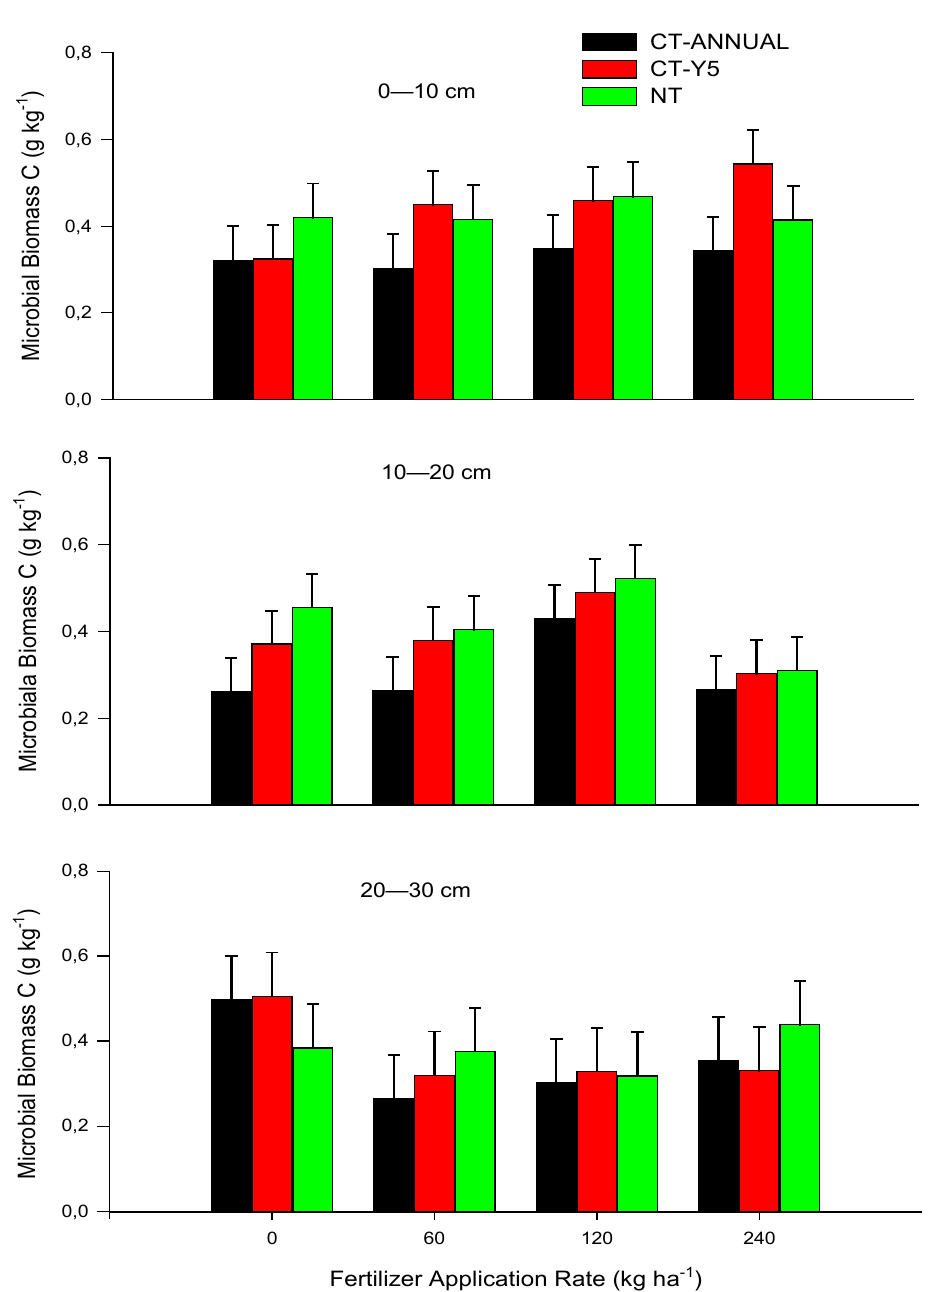
Figure 6 . Microbial biomass C with soil depths and urea application (kg N ha −1 ) for three tillage Figure 6. Microbial biomass C with soil depths and urea application (kg N ha − 1 ) for three tillage techniques.